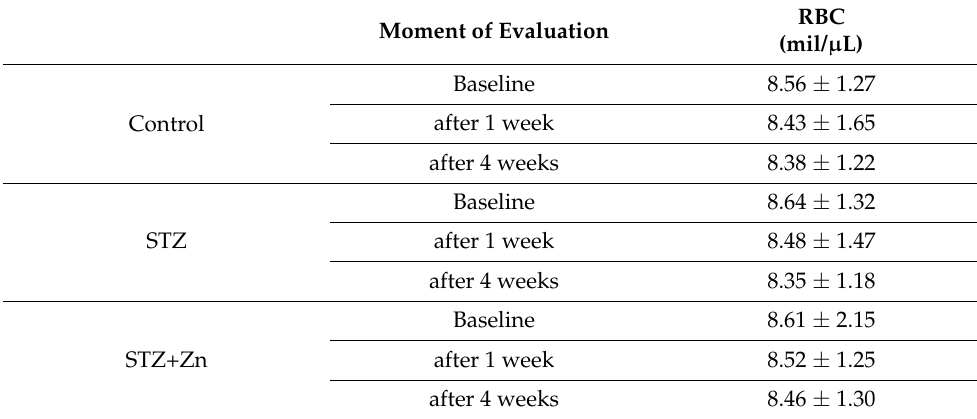
Table 1. The effect of Zn on number of RBC in diabetic rats. The values are presented as mean ± S.D. for 5 animals in a